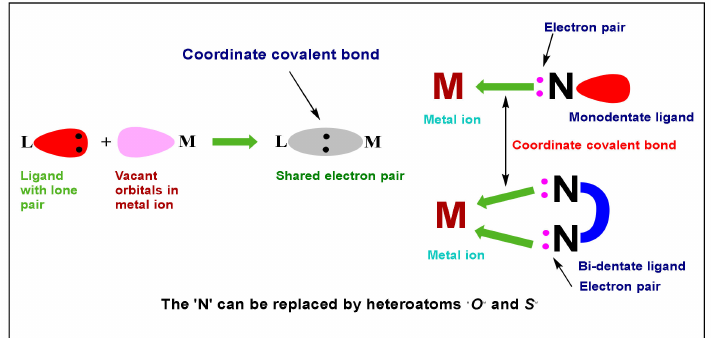
Figure 2. Schematic representation behind the formation of metal